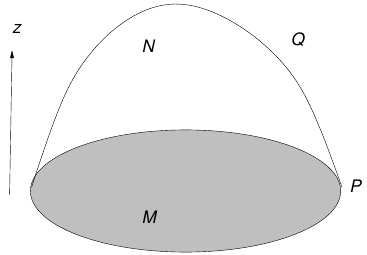
Figure 1 . BCFT on M and its dual N